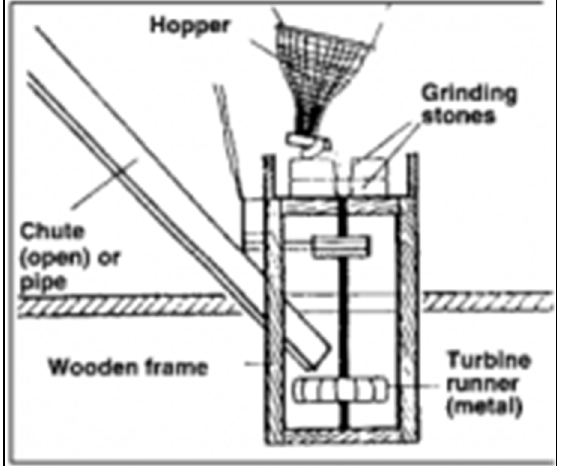
Figure 20. Water mills modified with a metal turbine (adapted from [33]).